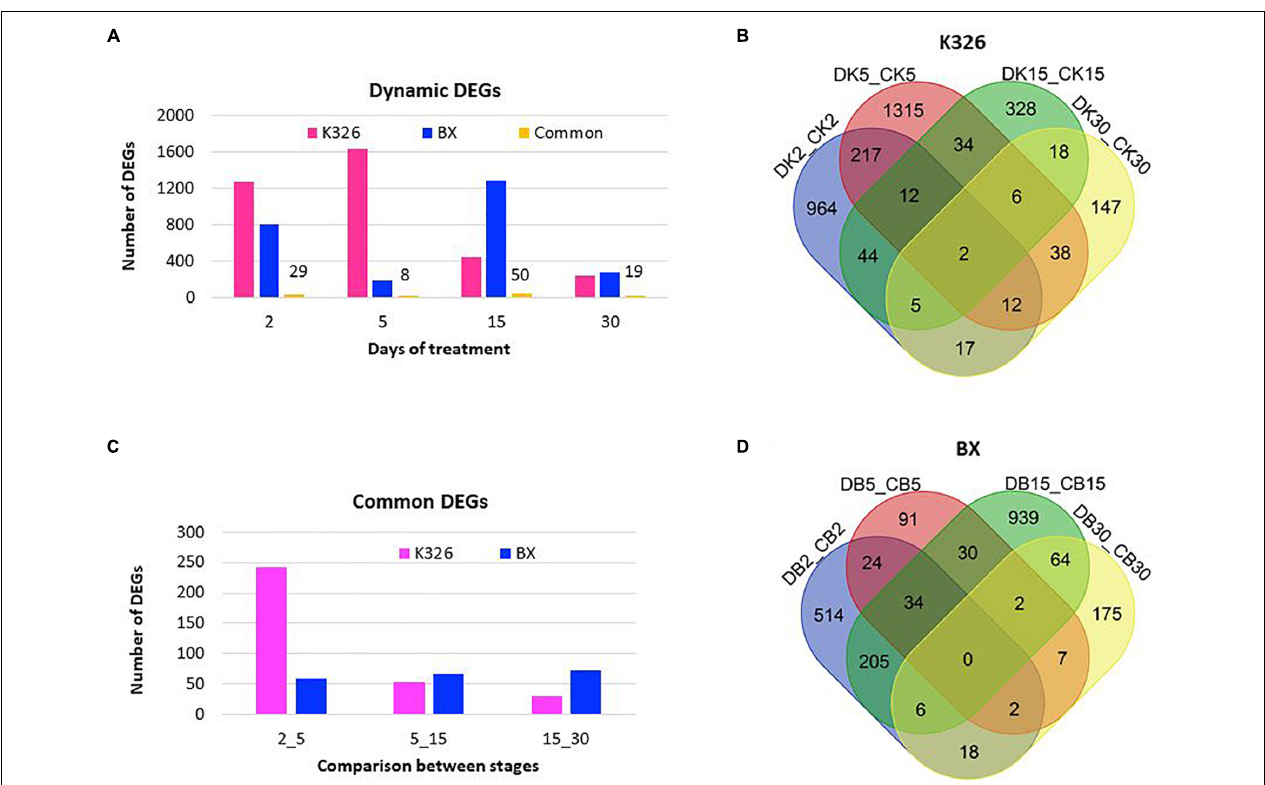
FIGURE 2 | Changes of DEGs in response to drought at time courses in N. tabacum varieties K32 and BX. (A) Differentially expressed genes (DEGs) with at least twofold changes in transcript abundance (FDR < 0.01) compared with controls at the same stage, and the common DEGs shared by two varieties at each stage, the number above the bar showing the number of shared DEGs. (B) Venn diagram showing DEG distribution between time courses in K326. (C) Shared DEGs between adjacent treatment stages. (D) Venn diagram showing DEG distribution between time courses in BX; Letters D, C, K, and B represent drought treatment, control, K326, and BX, respectively. Numbers 2, 5, 15, and 30 in the sample IDs represent days of drought treatment or control. DEGs were mined from three replicates of RNA-Seq data generated from six biological plants at each